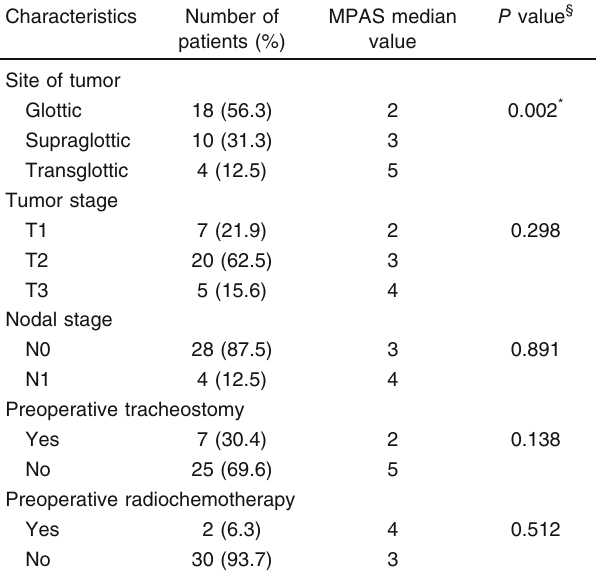
Table 3 Preoperative variables and its association with postoperative aspiration Characteristics